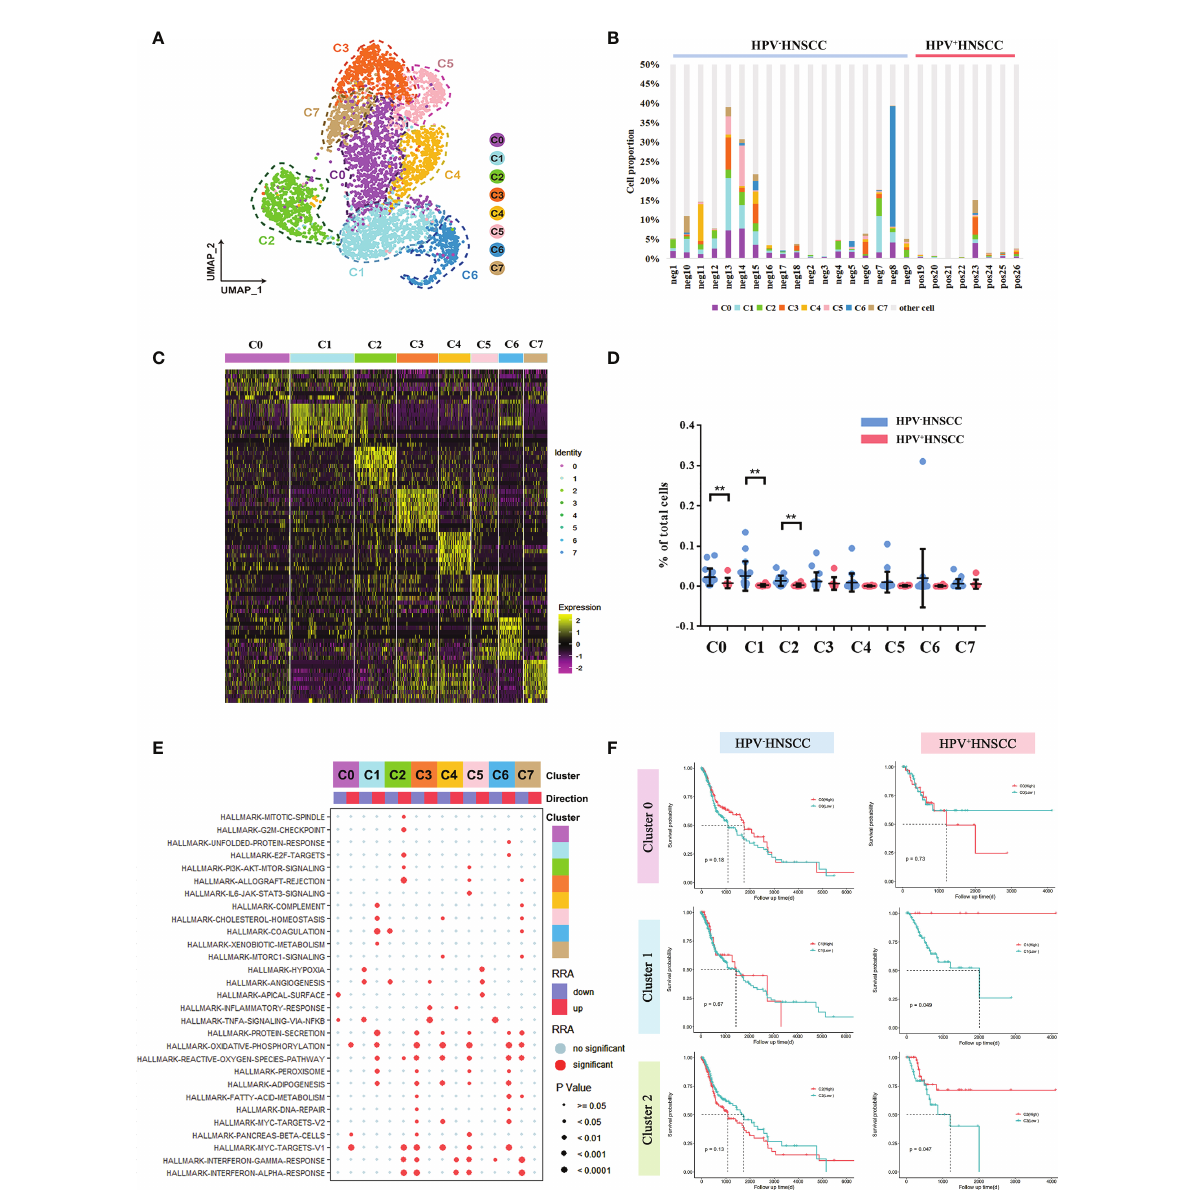
FIGURE 2 Macrophage subtype analysis based on single-cell gene expression. (A) The UMAP plot of macrophage subsets in HPV-related HNSCC. (B) The proportion of macrophage subsets in each sample. (C) The heatmap of the top 10 genes differentially expressed in each macrophage subset. (D) The frequency of macrophage subsets in total cells with HPV +/- HNSCC scRNA datasets ** P < 0.01. (E) The bubble chart of statistically signi fi cant differences in speci fi c gene sets from MSigDB with each macrophage subgroup. Light blue points represent no signi fi cant difference. The cluster tree on the left represents the similarity of expression patterns of different gene sets in different macrophage subsets. (F) Prognostic signi fi cance of C0, C1, and C2 assessed in HPV +/-